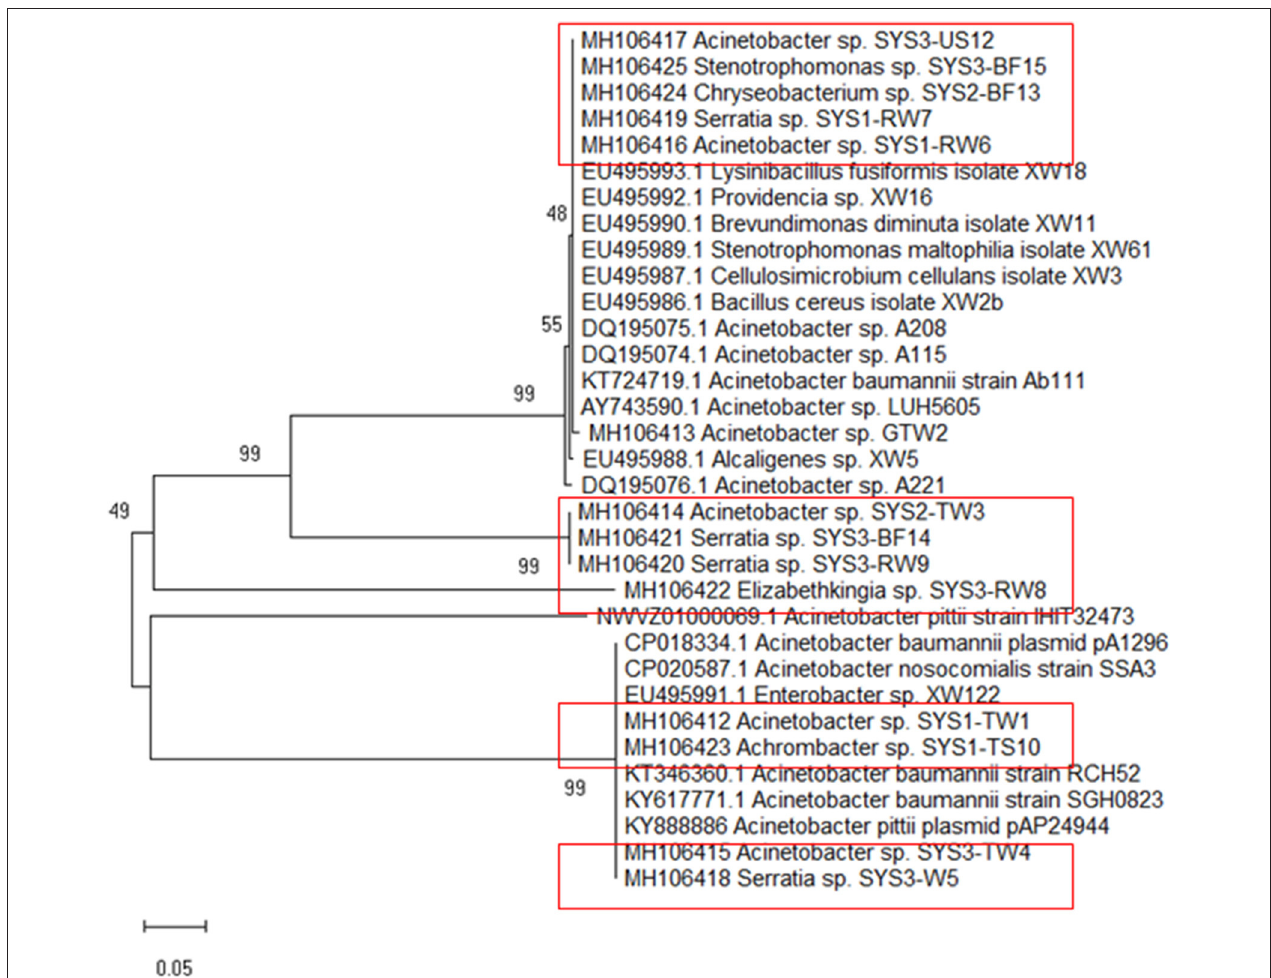
FIGURE 5 | Phylogenetic tree of tet 39 genes sequenced from the positive strains (in box) was inferred using the Neighbor-Joining method. The percentage of replicate trees in which the associated taxa clustered together in the bootstrap test (500 replicates) are shown next to the branches ( Kumar et al.,